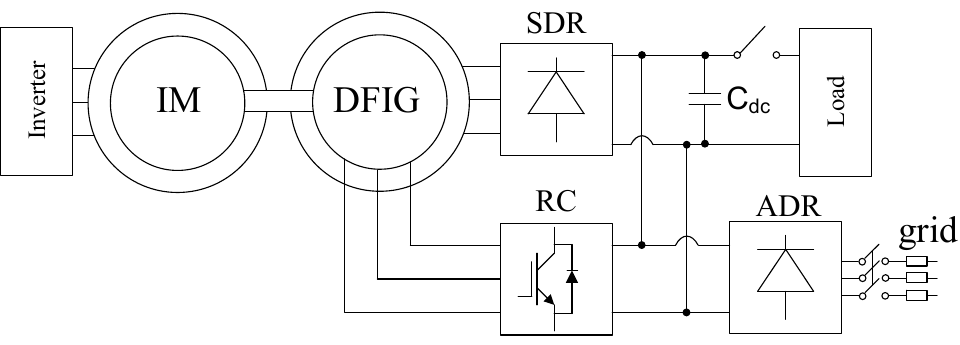
Figure 8. Scheme of the laboratory setup with a small-scale doubly fed induction machine.